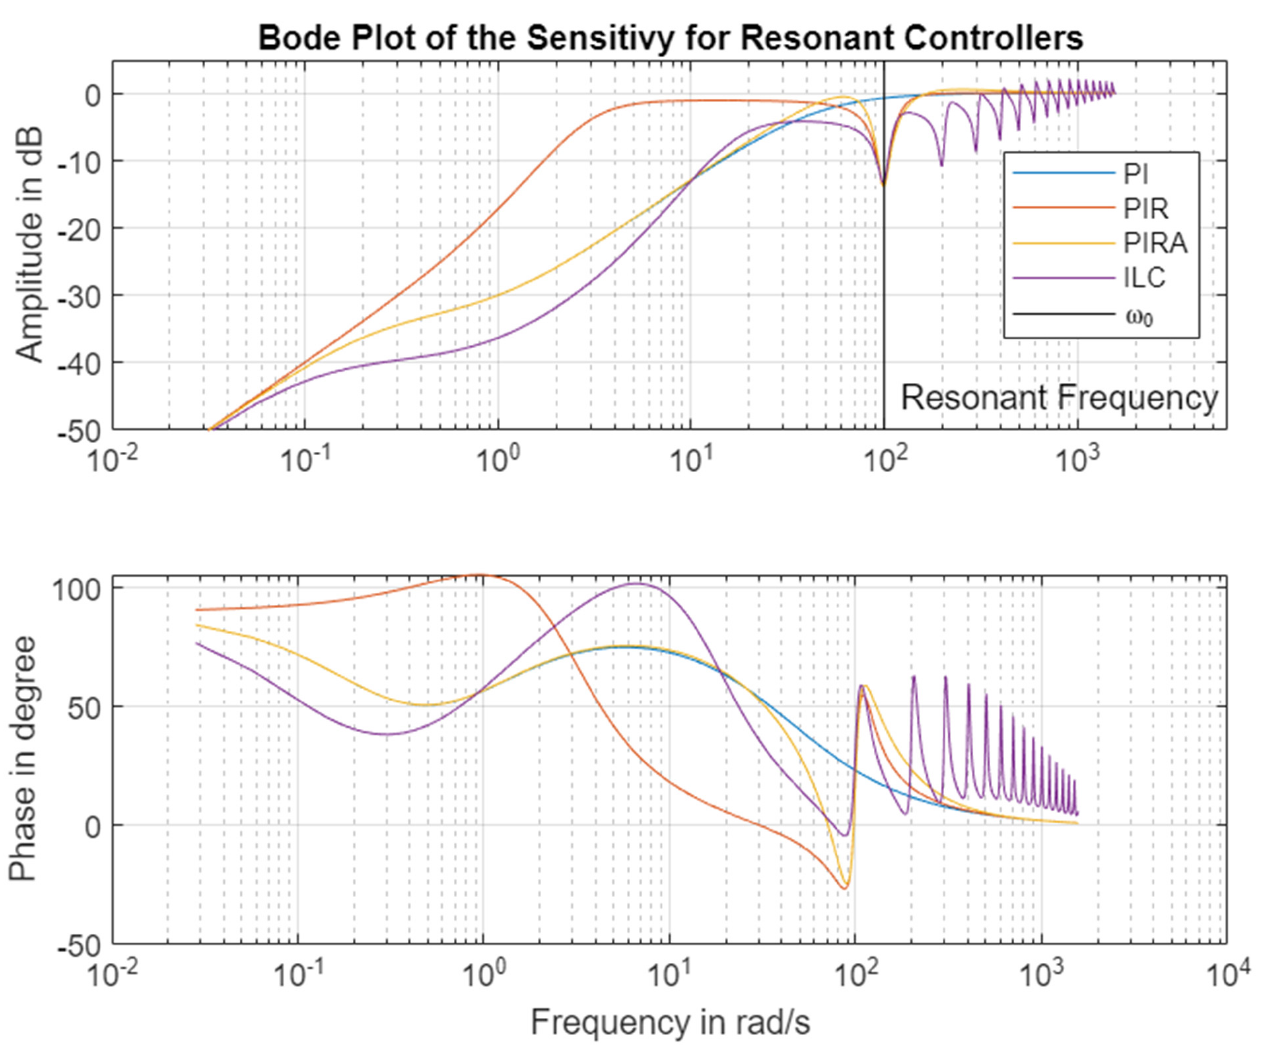
Figure 10. Bode Plot of the Closed Loop Sensitivity comparing all three controllers.